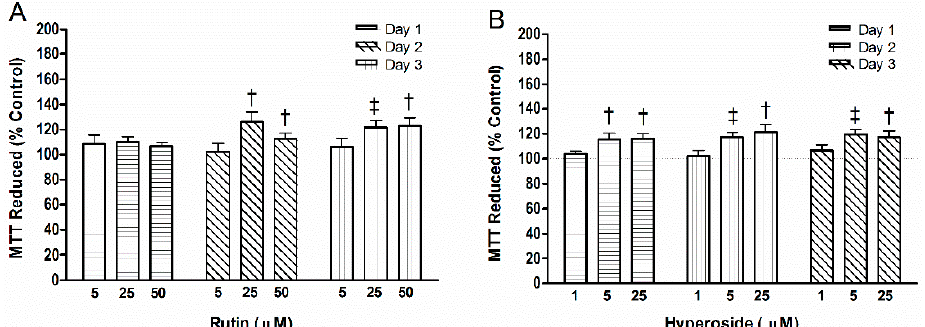
Figure 3. 3-(4,5-dimethyl-2-thiazolyl)-2,5-diphenyl-2H-tetrazolium bromide (MTT) levels reduced with addition of ( A ) rutin or ( B ) hyperoside. Activity was measured by the reduction of MTT. Significant differences are indicated by: † p < 0.05 and ‡ p < 0.01 compared to control within a day. Each bar represents n = 6.